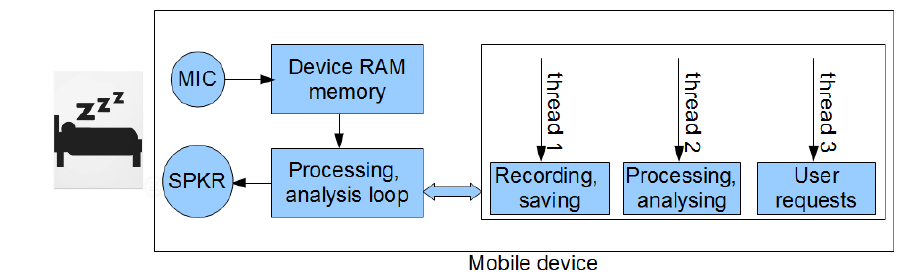
Figure 6. Block diagram of wakeNsmile application.